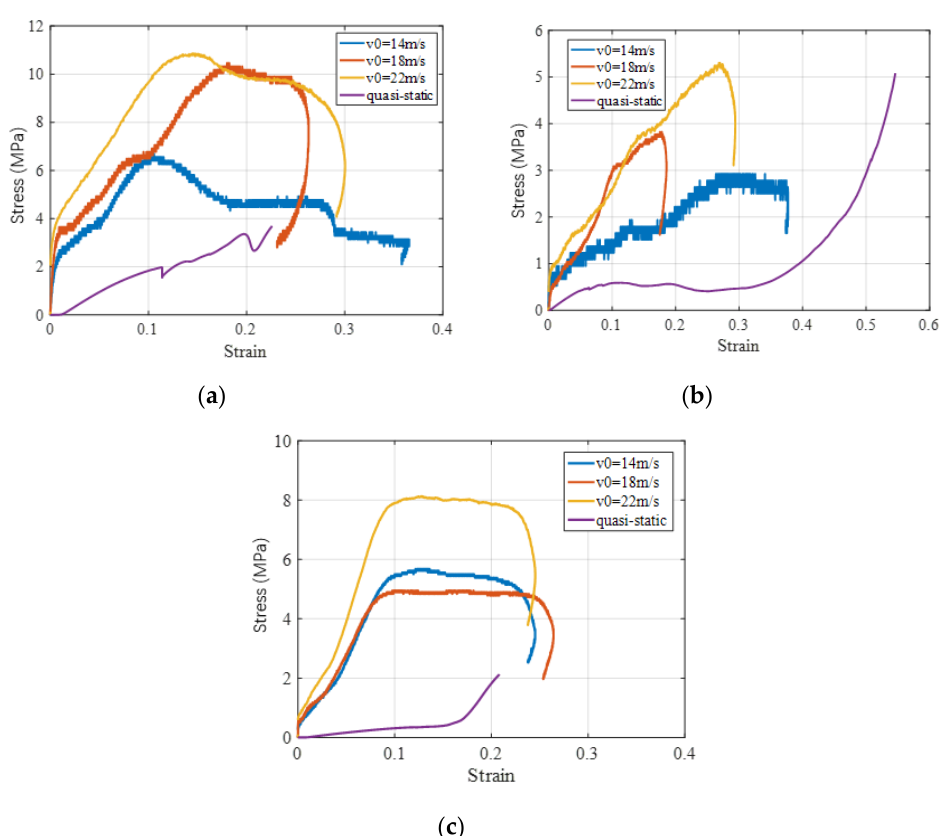
Figure 7. Comparison of stress–strain curves of specimens under different working conditions. ( a ) C2, ( b ) C3, ( c ) C5.